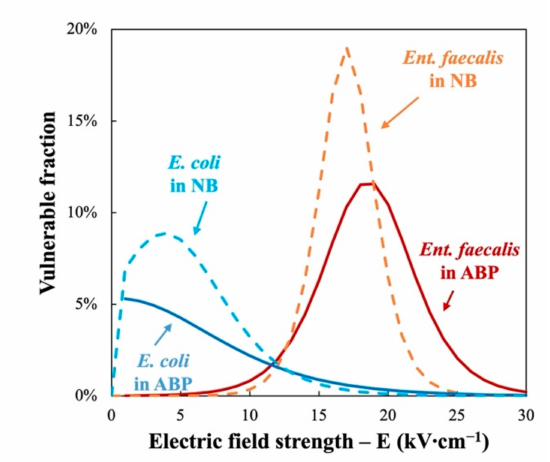
Figure 4. Distribution of vulnerable fraction of Ent. faecalis (red) and E. coli (blue) with regard to PEF treatment in nutrient broth (NB, dotted curves) and animal by-products (ABP, solid